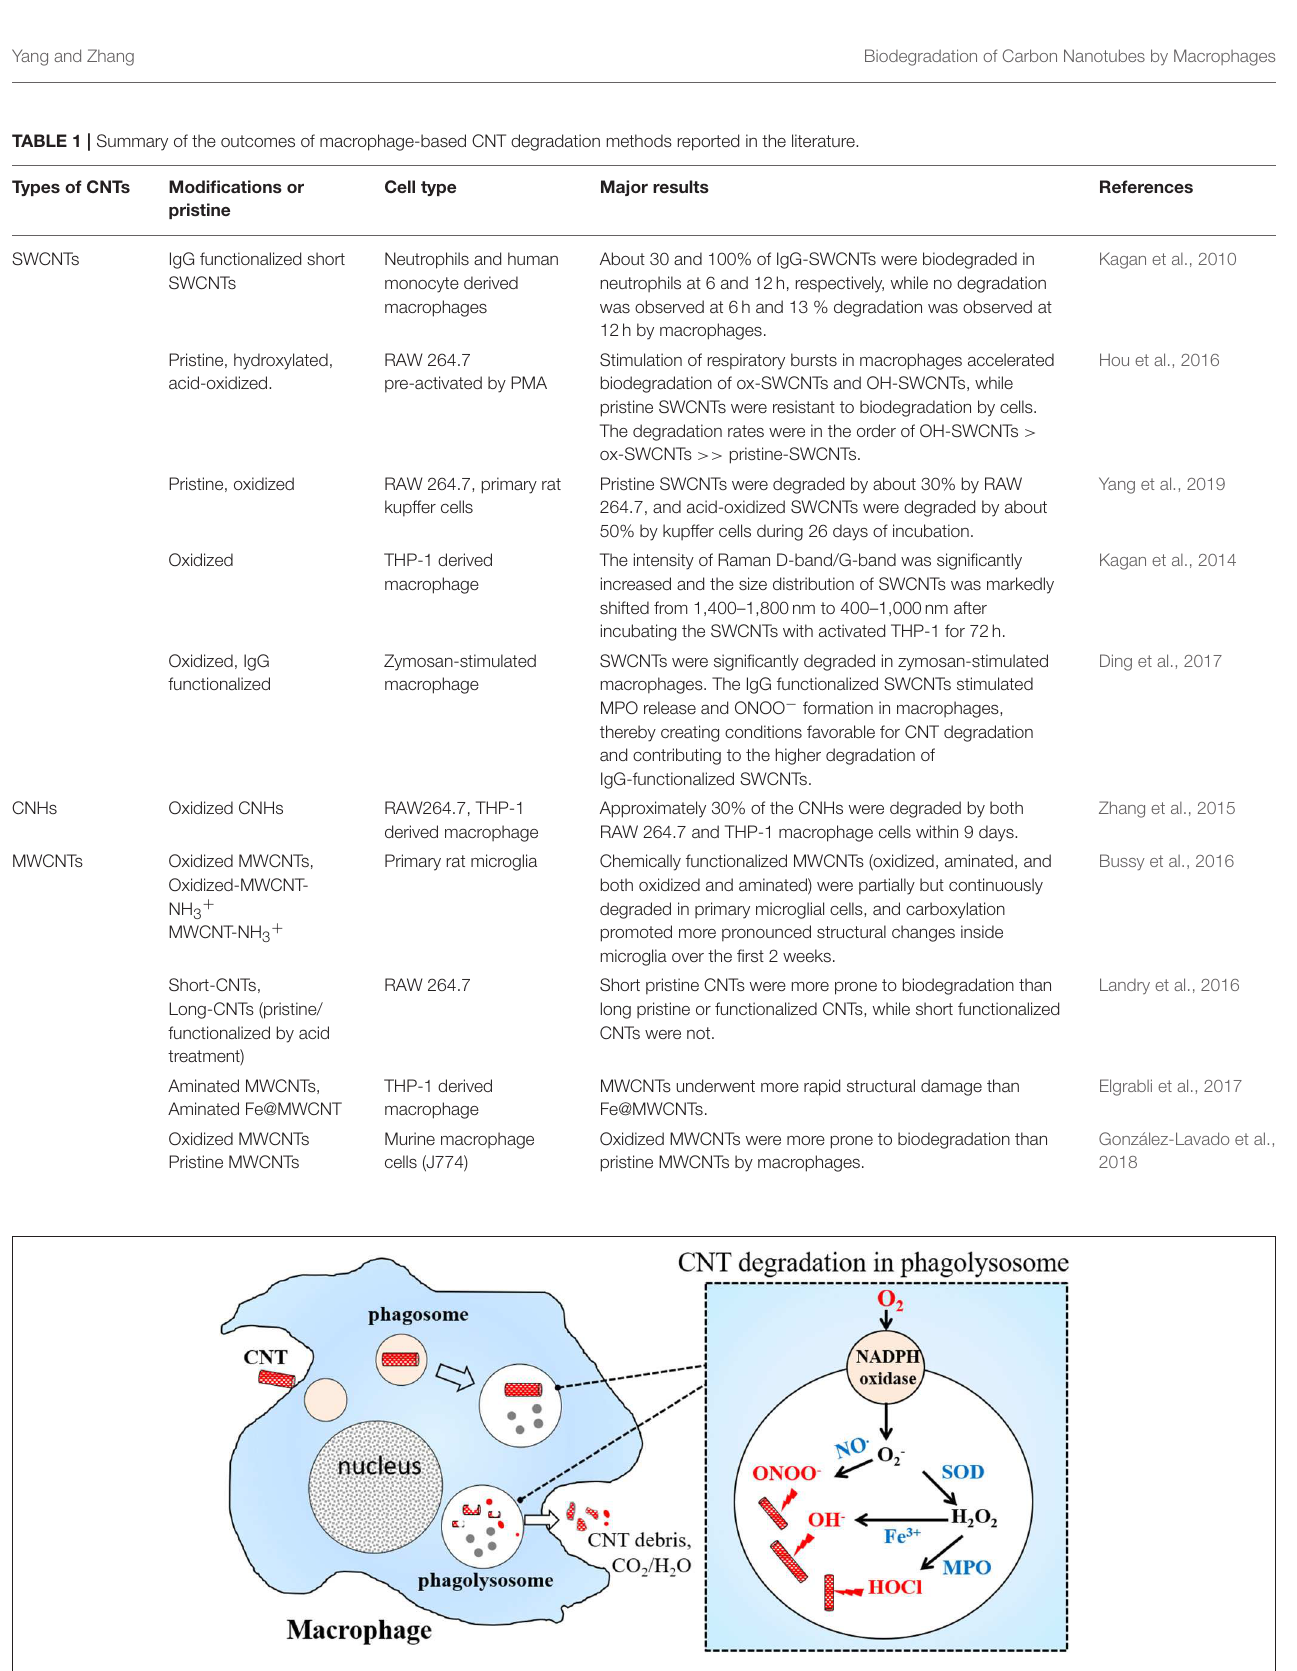
FIGURE 1 | A scheme of CNTs degradation in